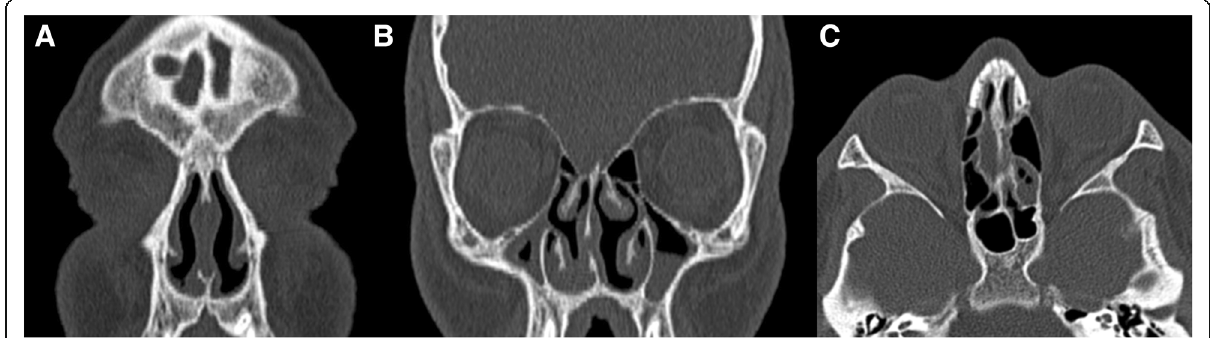
Fig. 3 Coronal ( a , b ) and axial ( c ) reconstruction of paranasal sinus CT of a 21-year-old Down syndrome patient, depicting absent frontal sinuses and hypoplasia of the maxillary and sphenoid sinuses